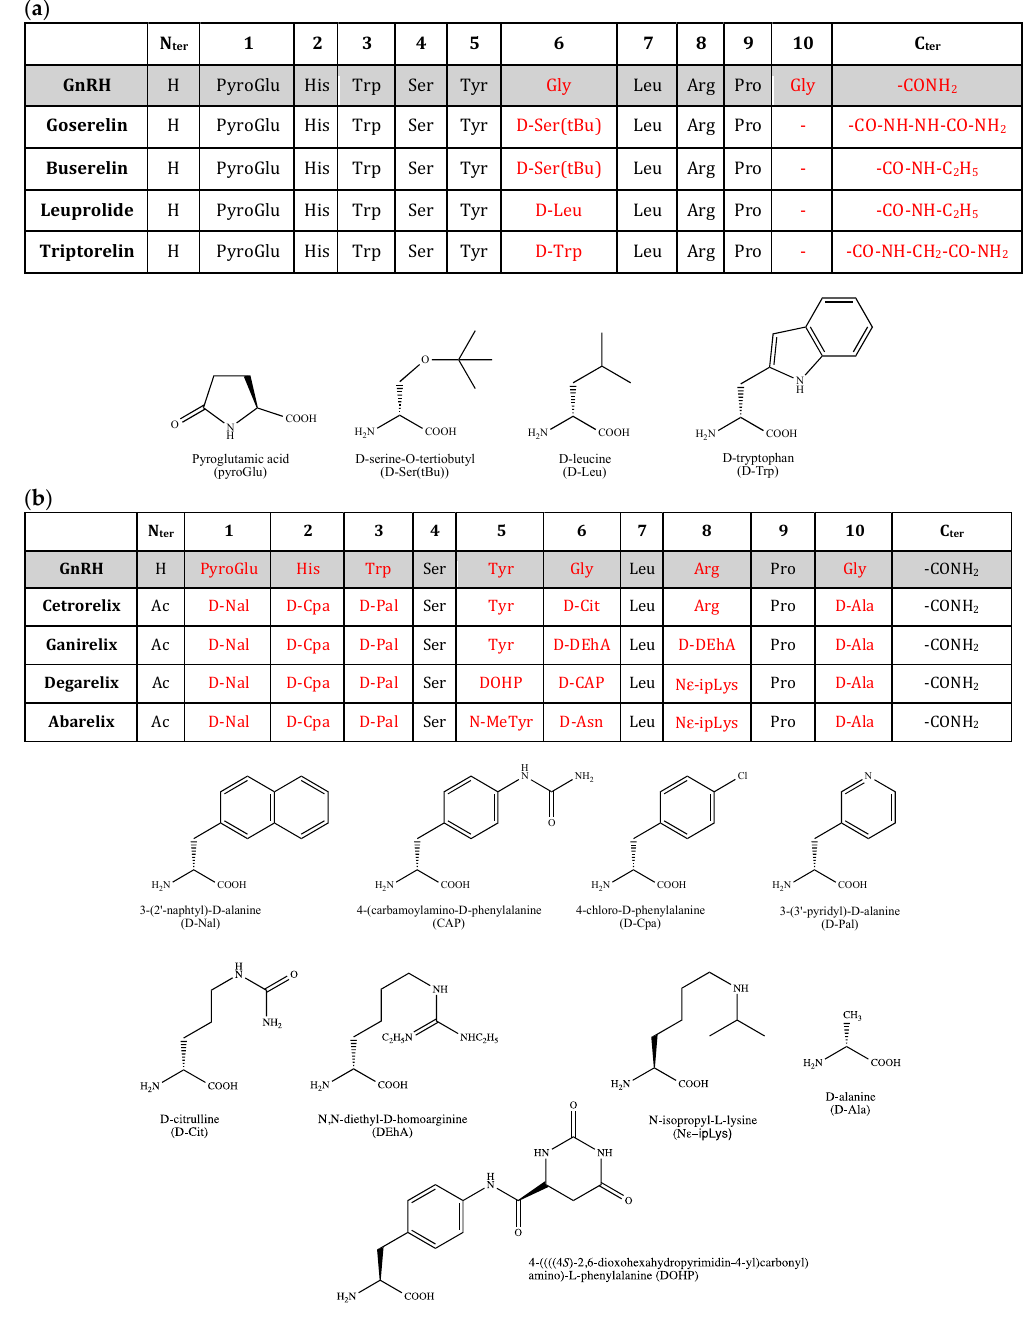
Figure 8. Structure of ( a ) GnRHR agonists (goserelin, buserelin, leuprolide and triptorelin) and ( b ) GnRHR antagonists (cetrorelix, ganirelix, degarelix, and abarelix). The residues that are subject to pharmacomodulation are indicated in red. The structures and symbols of the non-proteinogenic amino acids of these molecules are specified.